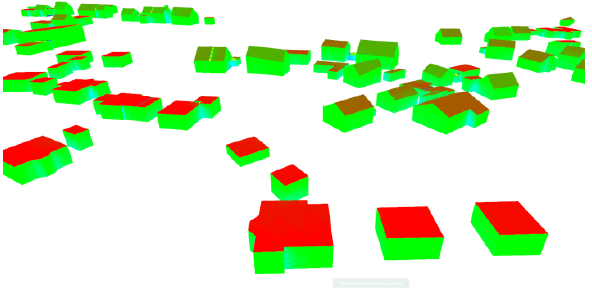
Figure 16 Solar radiations on Buildings in Finsterrot